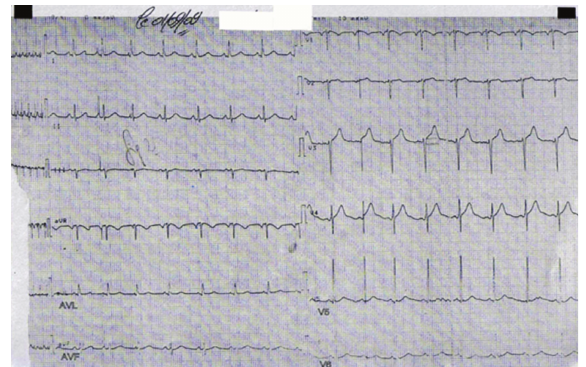
Figure 1: Sinus tachycardia, increase of T wave amplitude in leads V 3 and V 4 with 3 mm subsegment elevation ST.